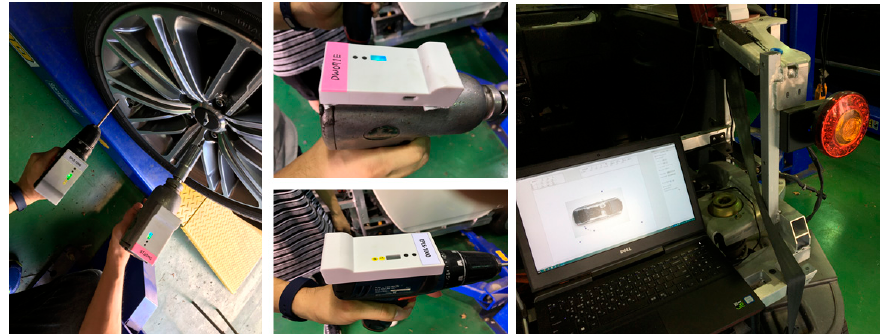
Figure 11. Tool position tracking experiment in real working environment.